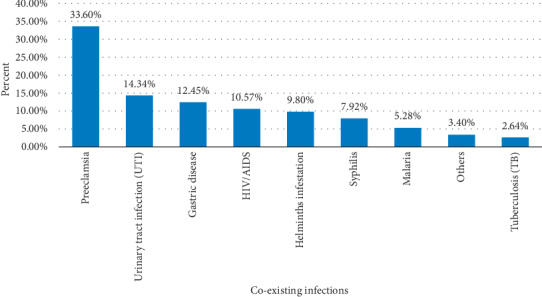
Magnitude of coexisting infections among postnatal mothers in Debre Markos Referral Hospital, Northwest Ethiopia, 2019. ∗Others include liver disease, heart disease, and pneumonia.